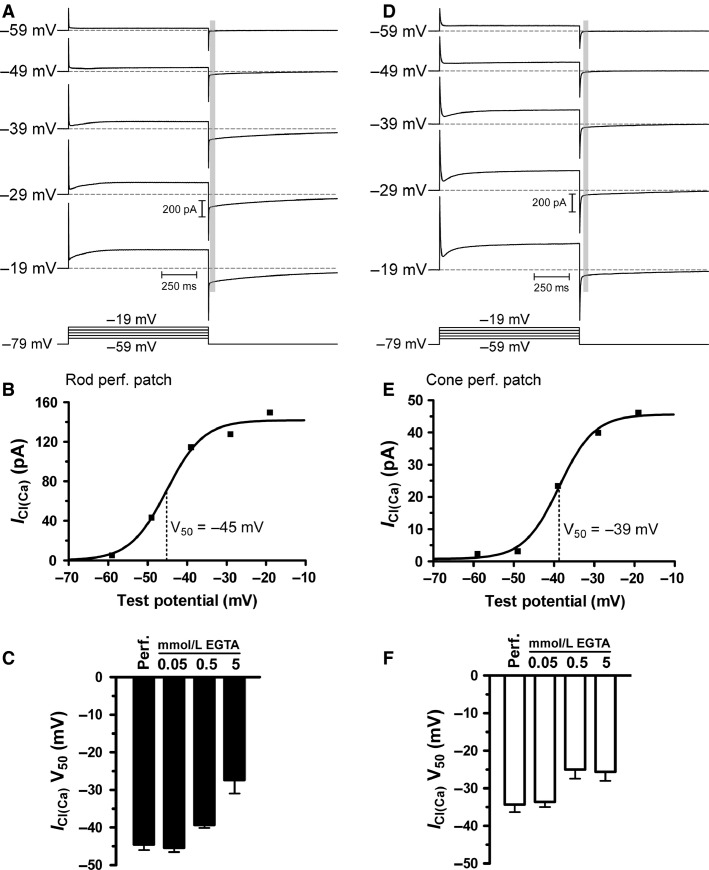
Effects of endogenous and exogenous Ca2+ buffers on Ca2+-activated Cl– current activation. (A) ICl(Ca) activation in a perforated patch recording from a rod. ICl(Ca) amplitude was measured following depolarizing voltage steps (1 sec duration) to –59, –49, –39, –29, and –19 mV from a holding potential of –79 mV. ICl(Ca) was measured from the prestep baseline (dotted line) after the decay of the whole cell capacitance transient. The measurement region is indicated by the vertical gray bar. (B) Current–voltage relationship of ICl(Ca) from the rod in A, fit with a Boltzmann sigmoid. The voltage of half-maximal activation (V50) was –45 mV in this rod. (C) Group data comparing ICl(Ca)
V50 measurements with different concentrations of the exogenous Ca2+ buffer EGTA or when endogenous buffers were kept intact by recording in perforated patch configuration. The perforated patch V50 most closely matches the 0.05 mmol/L EGTA condition. (D) ICl(Ca) recorded in a single cone using perforated patch techniques, as in A. (E) Current–voltage relationship showing a V50 for ICl(Ca) activation in this cone of –39 mV. (F) Group data showing that for cones, V50 recorded with perforated patch was most similar to the V50 recorded with 0.05 mmol/L EGTA.